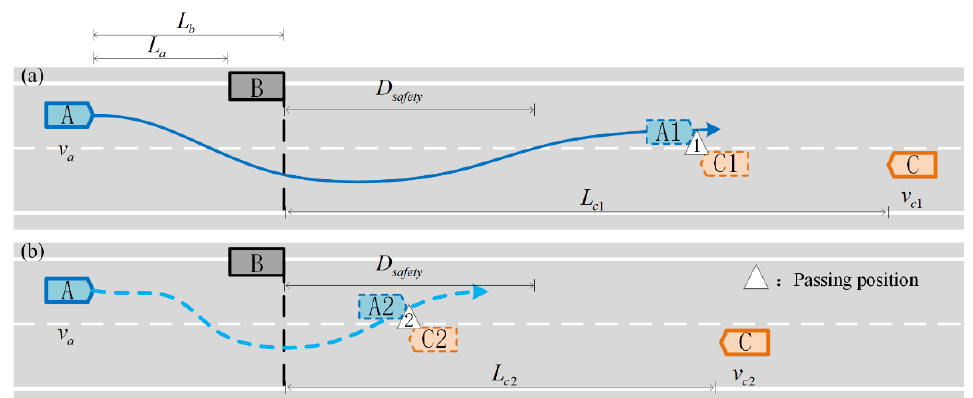
Figure 2. Different passing position when ego vehicle keeps speed constant during overtaking ( a ) The passing position is at a safe position ( b ) The passing position is too close to the parked vehicle.